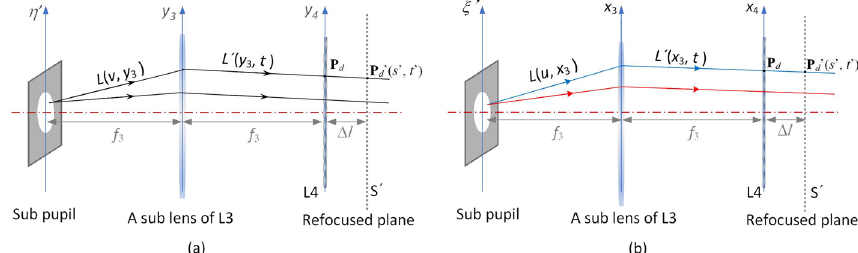
Fig. 4 The optical layout for digital refocusing of each slit light field image. a is illustration in y direction, and b is the illustration in x direction, i.e., the dispersion direction. The image is assumed to be refocused on S’ plane, and the ray L ’ intersects plane S’ at point P d